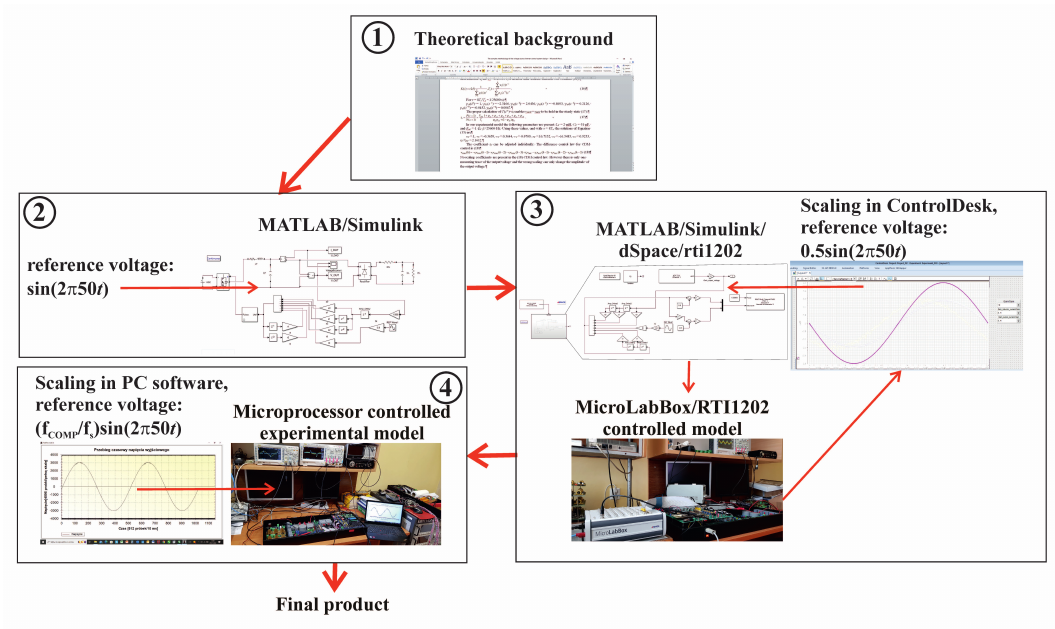
Figure 1. Flowchart of the modern VSI controller design